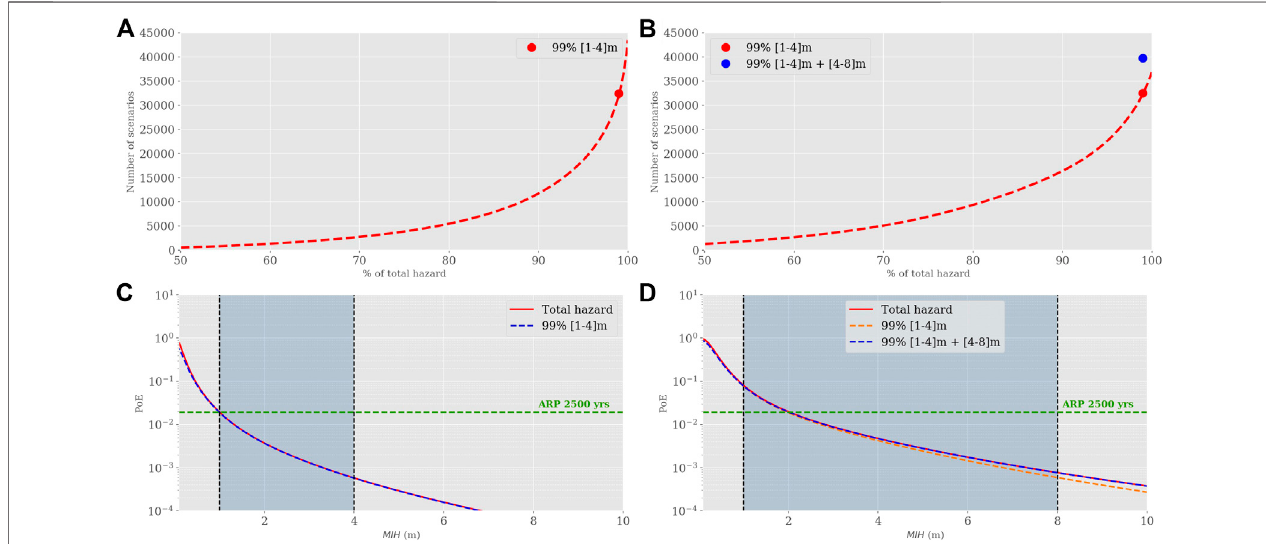
FIGURE9| Numberofscenariosneededtorepresentthe99%( Table1 )ofthetotalhazardforbothtargetsites[Catania,inpanels (A) andSiracusa,inpanel (B) ]in the selected interval of tsunami intensity (range [1 – 4] m for Catania and ranges [1 – 4] and [4 – 8] m for Siracusa). The corresponding hazard curves [panels (C) and (D) for Catania and Siracusa, respectively] in the respective MIH ranges are overlapped with the ones representing the total hazard. For Siracusa results without the [4 – 8]m range are shown to illustrate the discrepancy with respect the total hazard curve [orange line in panel (D) ] and the number of additional scenarios [blue dot in panel (B) ] needed to well represent the total